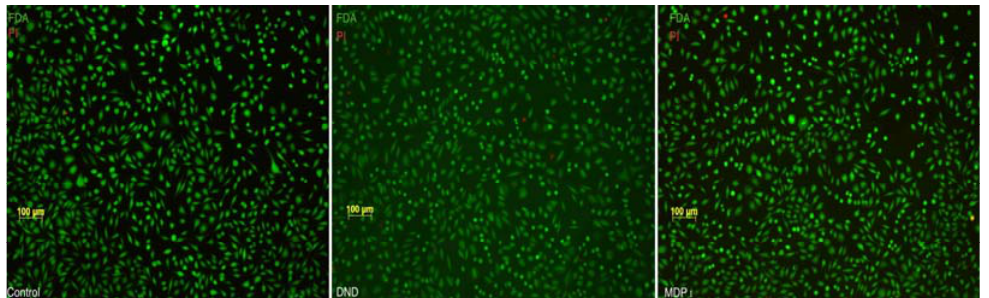
Figure 3. The pictures from the fluorescence microscope (Axio Observer [Zeiss]) show the fibroblast line, clone L929 (green fluorescense) in control without carbon nanomaterials, and in presence of DND ‐ pure detonation nanodiamonds and plasma ‐ chemically modified detonation nanodiamonds (MDP1).